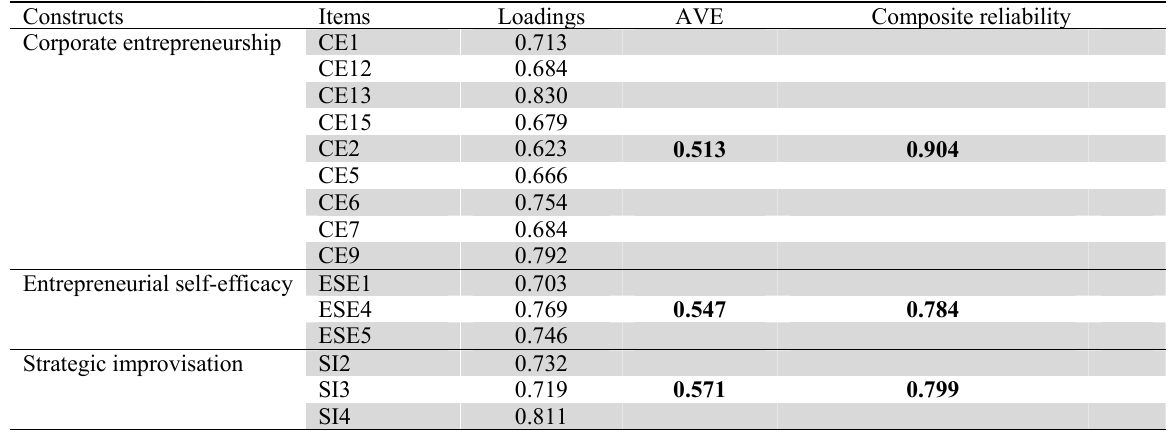
Construct validity and reliability